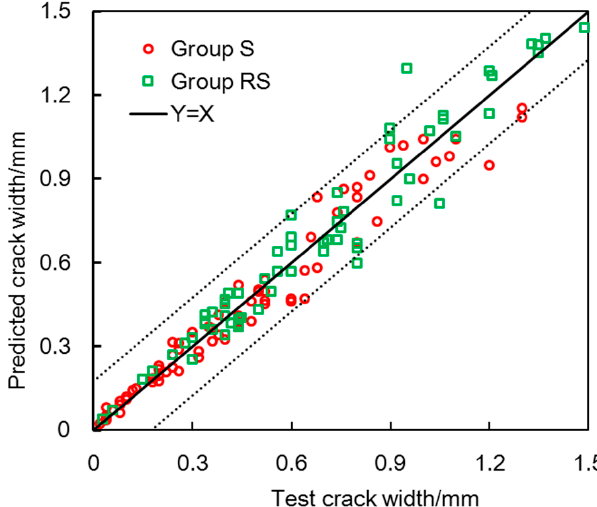
Figure 16. Predicted and test crack widths.